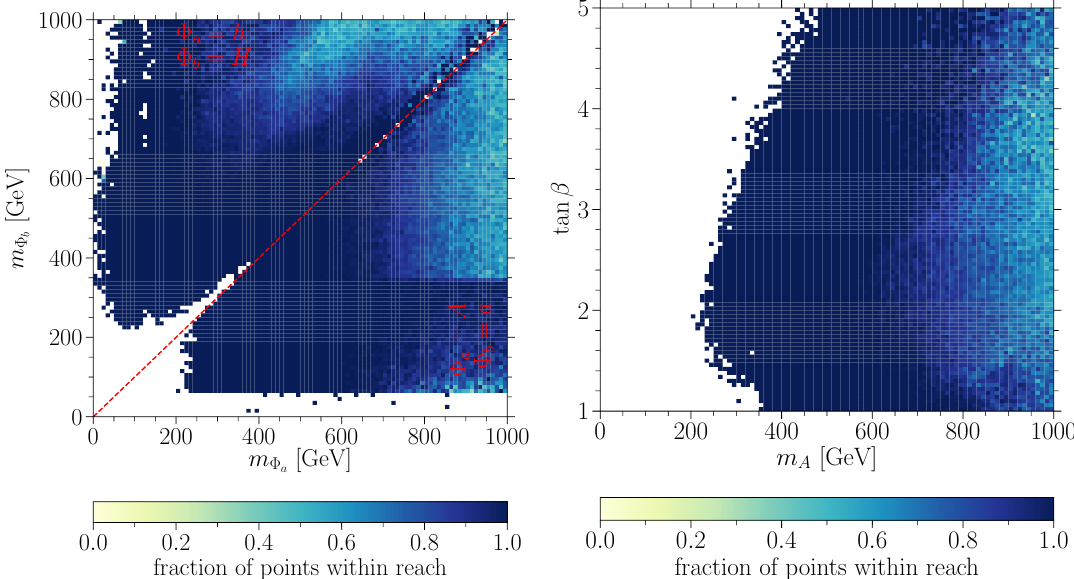
Figure 10 . Same as (cid:12)gure 9 but the left panel shows the distribution of LHC sensitivity for all the masses: non SM-like CP-even masses m H vs. m h in the top left triangle, and CP-odd masses m A vs. m a in the lower right triangle. The right panel instead shows the sensitivity in the conventional m A -tan (cid:12) plane predominantly used when presenting results in the